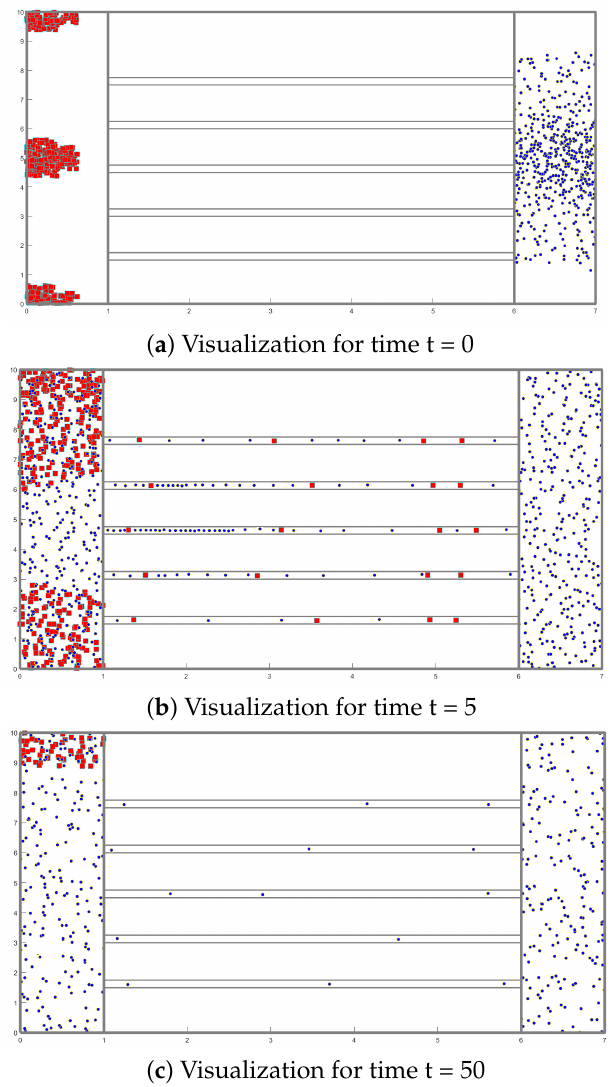
Figure 11. Visualization of immune cells (blue dots) and tumor cells (red squares) for times t = 0, t = 5, and t = 50 using the density of each quantity and representing them as